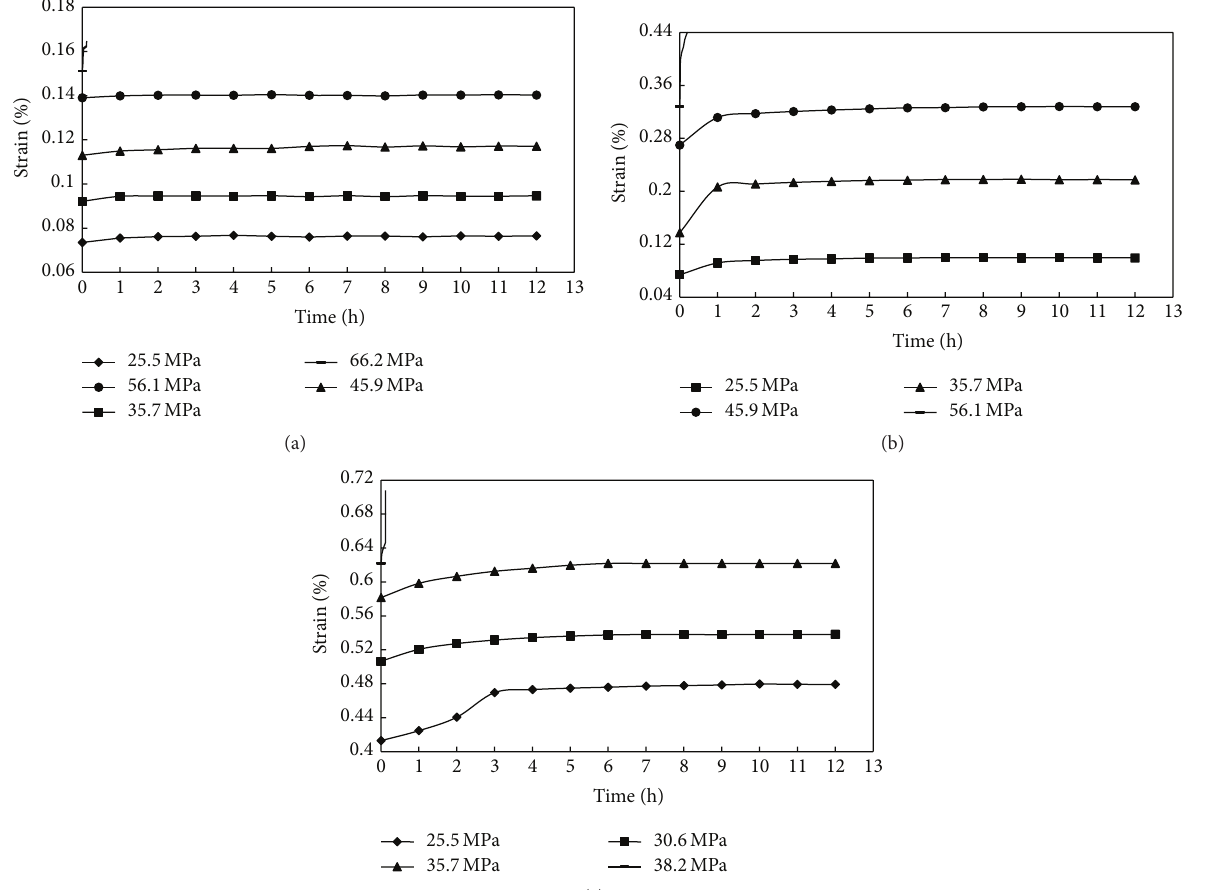
Figure 5: Curves showing relation between strain and time of specimens with different saturation degrees: (a) 𝑆 = 41.5 %; (b) 𝑆 = 80.1 %; (c) 𝑆 = 93.5